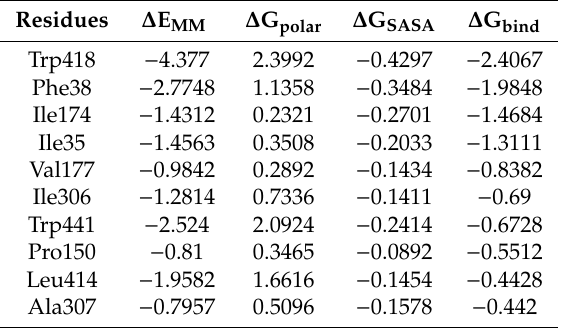
Table 3. Decomposition of binding free energy (kJ / mol) on per-residue basis of